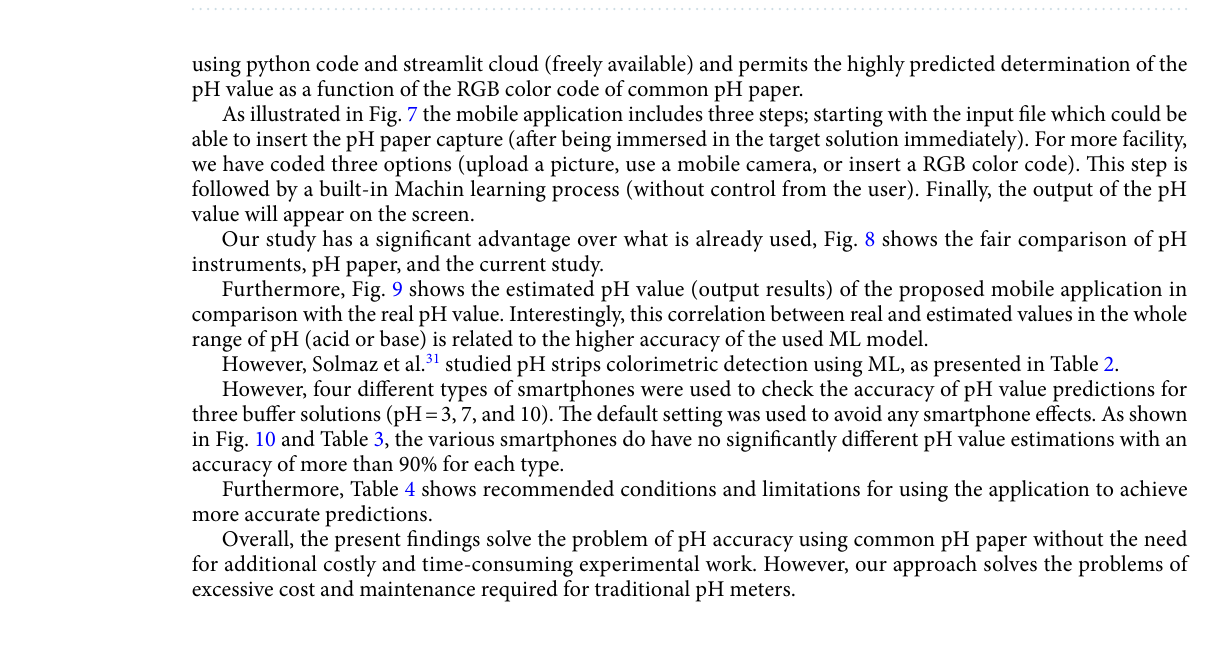
Figure 6. The model’s prediction results (based on the test data) vs. experimental